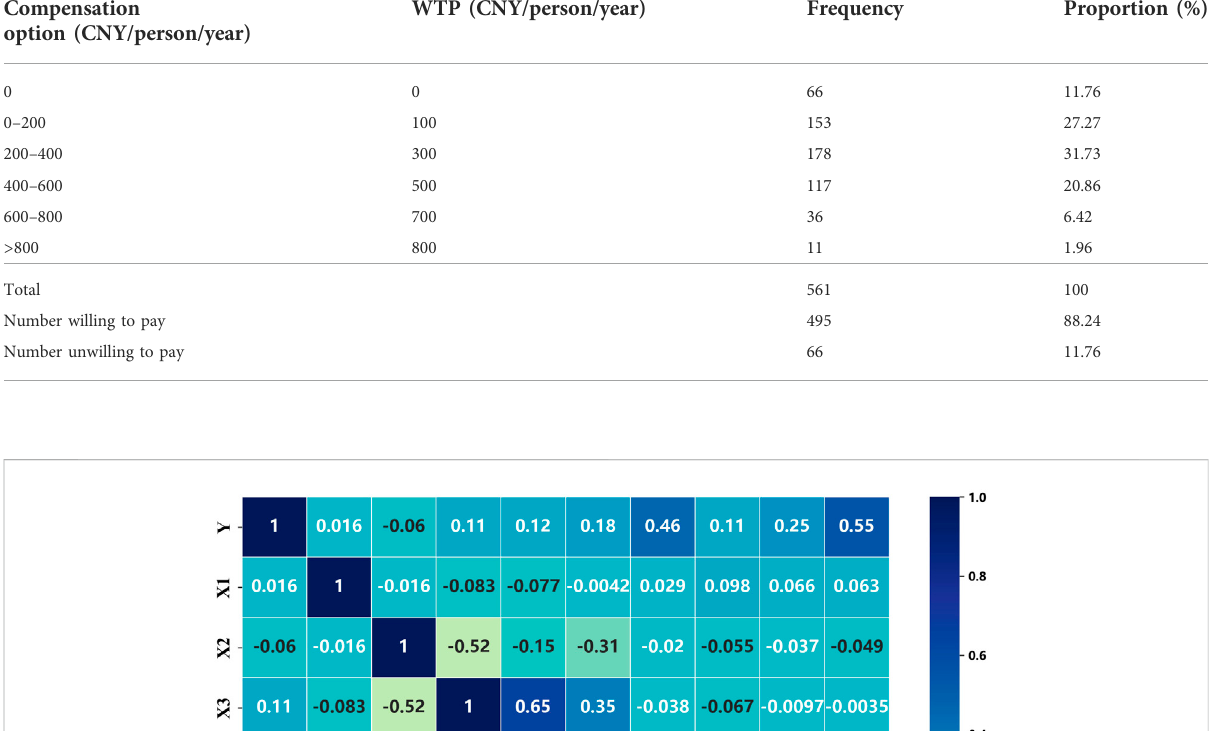
TABLE 4 Distribution of respondents ’ WTP values.